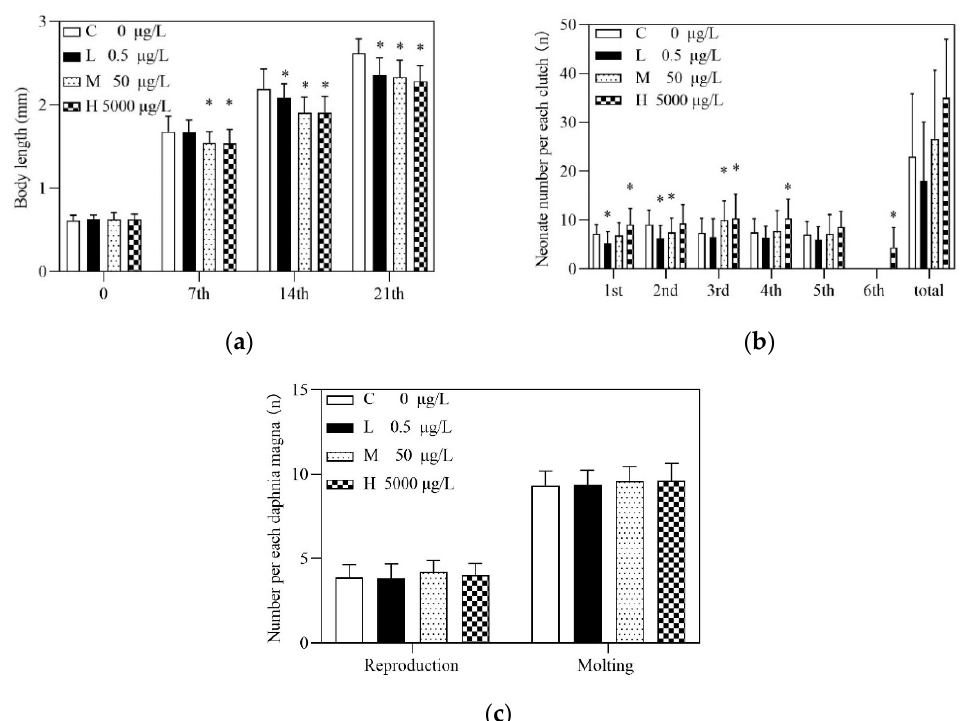
Figure 2. Growth parameters in D. magna after 21 d exposure to pravastatin sodium (PRA): ( a ) Body length growth in D. magna during 21 d test; ( b ) Offspring per each clutch in D. magna during 21d PRA exposure test; ( c ) The average number of reproduction (left) and molting (right) of each D. magna during 21 d PRA test. C, L, M and H represent the control, low, medium and high PRA treatment groups, respectively. An asterisk (*) indicates that the parameters of PRA treatment groups are significantly different from control ( p < 0.05; n = 60).